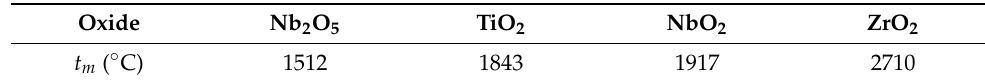
Table 7. Melting temperature of